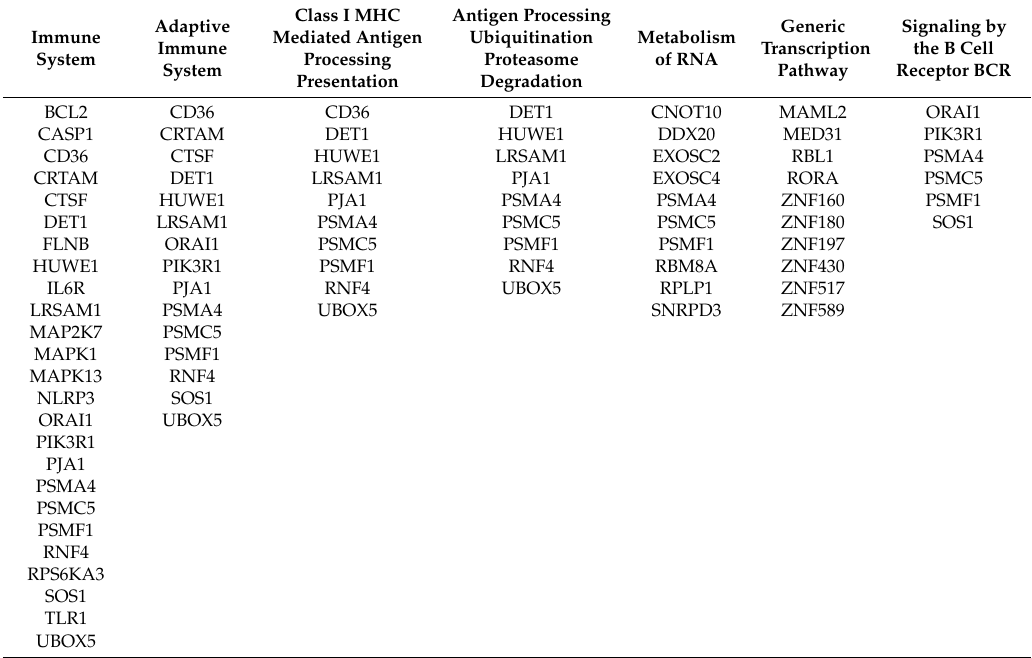
Table 3. Table of overlap genes from our analysis in the first seven enriched pathways from Table 2.